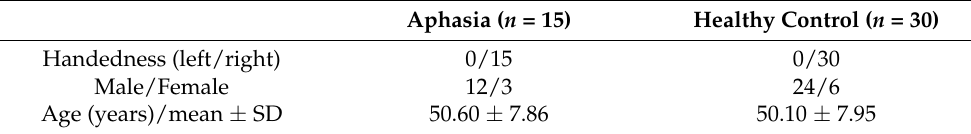
Table 1. Demographics of the patients with aphasia and healthy controls.